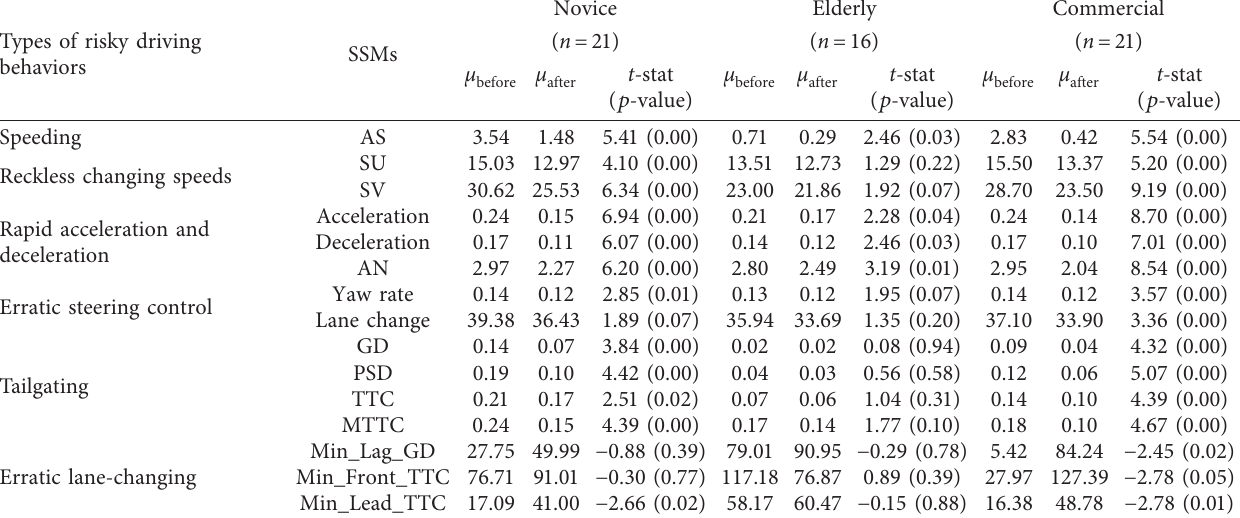
Table 4: Summary of statistics for surrogate safety measures in before and after